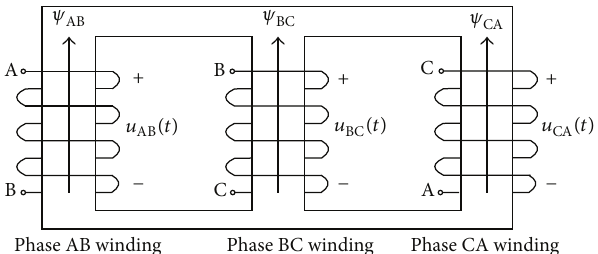
Figure 3: Connection of the primary windings of the delta/wye transformer.